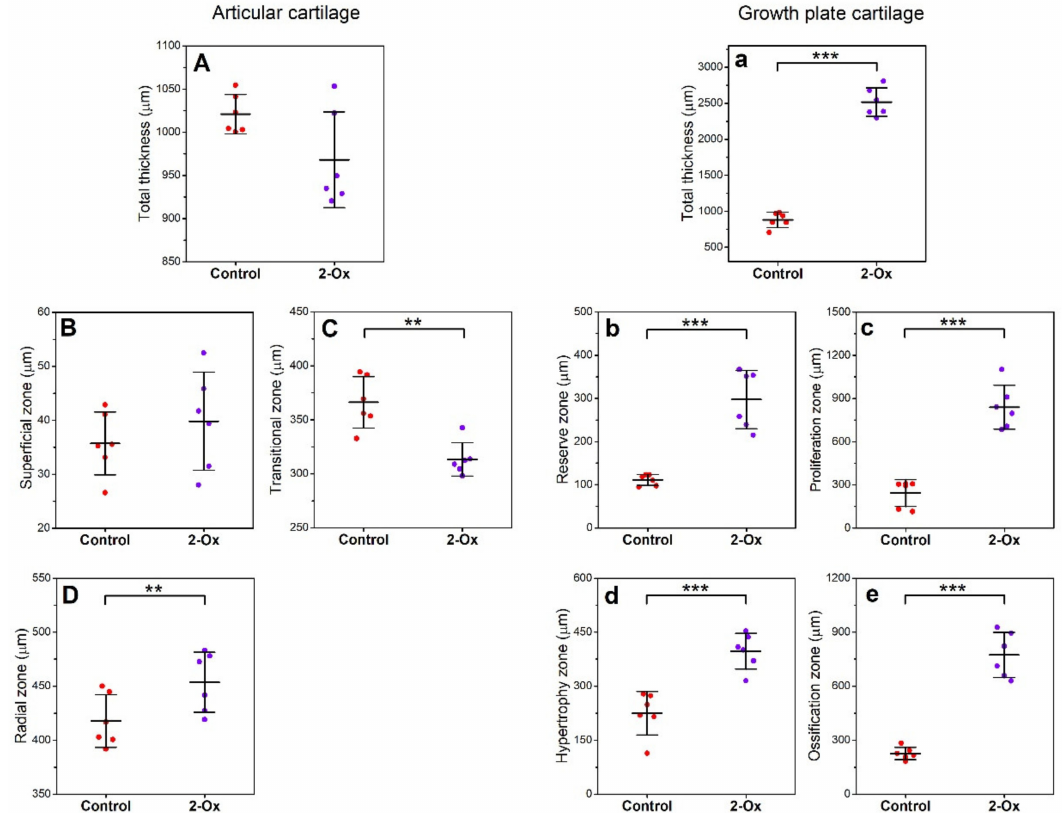
Figure 4. The e ff ect of dietary supplementation with 2-Ox on the thickness of zones in femoral articular cartilage and growth plate cartilage in glucocorticoid-induced, growth-retarded, mature gilts. Articular cartilage: ( A ) total cartilage thickness; ( B ) superficial zone; ( C ) transitional zone; ( D ) radial zone. Growth plate cartilage: ( a ) total cartilage thickness; ( b ) reserve zone; ( c ) proliferation zone; ( d ) hypertrophy zone; ( e ) ossification zone. Control—the control group included growth-retarded gilts not supplemented with 2-Ox; 2-Ox—the 2-Ox group included growth-retarded gilts supplemented with 2-Ox at a dose of 0.4 g / kg b.w. / day. Data are mean values ± SD (whiskers) from n = 6 gilts. Statistical significance: * p < 0.05; ** p < 0.01; *** p < 0.001 (two-tailed Student’s t -test or Mann–Whitney U